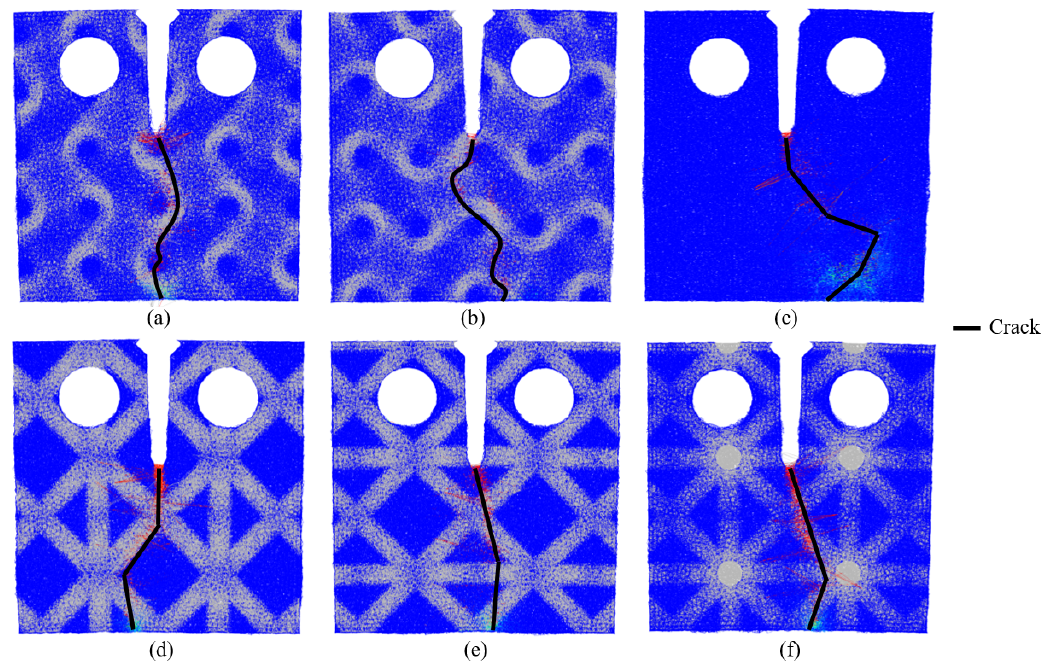
Figure 13. Crack paths in the metal which surrounds the MS-TiC topologies (MS) according to the failure stress of the DEM bonds. The red color of the bonds corresponds to the MS failure stress. Gyroid_01 ( a ), Gyroid_02 ( b ), octet-truss ( c ), FBCZZ_01 ( d ), FBCCZ_02 ( e ) and FBCCZ_03 ( f ).